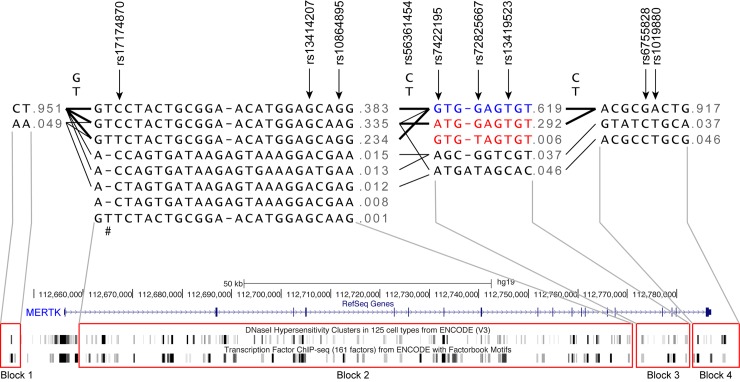
The haplotype structure of variants identified in MERTK.The 52 variants in MERTK genotyped for association with MS susceptibility fall into 4 separate blocks. Haplotype blocks are connected with thick lines if connections are observed in >10% samples and thin lines if connections are observed in >1% samples. A schematic of the MERTK gene is shown underneath indicating the relationship of the blocks to the physical structure of MERTK. The haplotypes coloured in red are significantly associated with MS susceptibility (p<0.05) and the haplotype coloured in blue is associated with protection (p<0.05). The p-value of association was determined using a Chi-square test. #This variant represents a tri-nucleotide in-del (T/- = TGG; -)